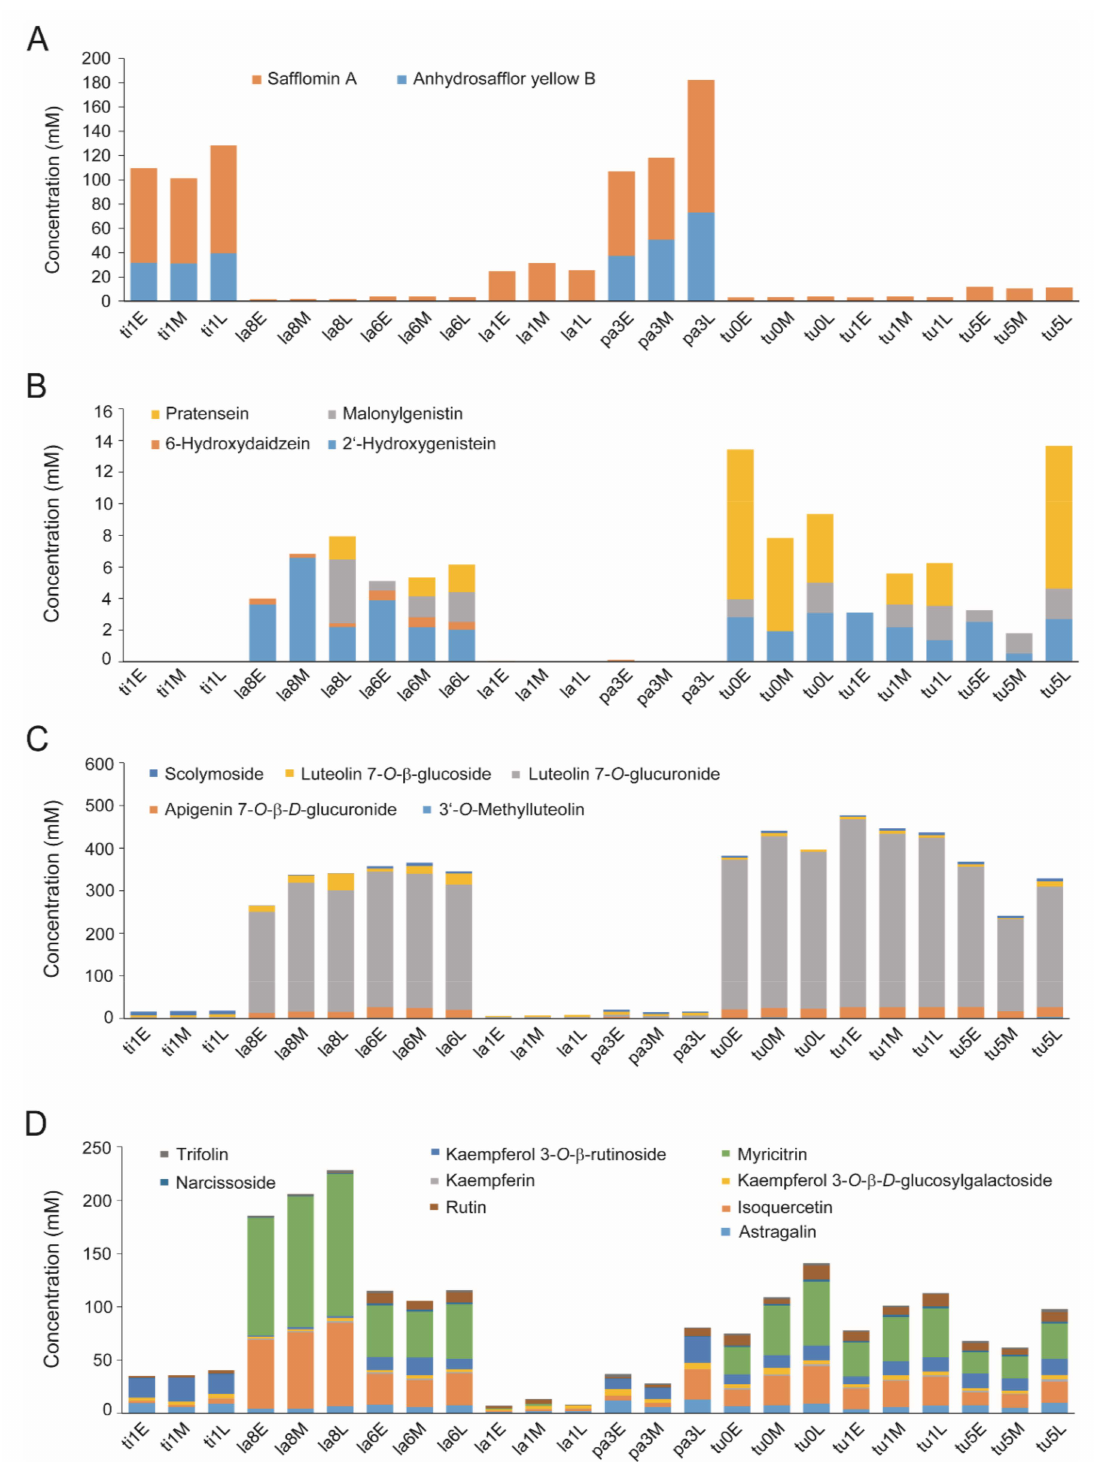
Figure 4. Cumulative distribution of chalcones ( A ), isoflavonoids ( B ), flavones ( C ), and flavonols ( D ) in wild sa ffl ower florets at di ff erent developmental stages. Sample name abbreviations: the first two letters indicate the first two letters of the species name, the number indicates the last digit of the PI number, and the letters E, M, and L indicate early, middle, and late stages of development, respectively. For example, “ti1E” indicates the sample PI 592391 ( C . tinctorius ) at the early stage of